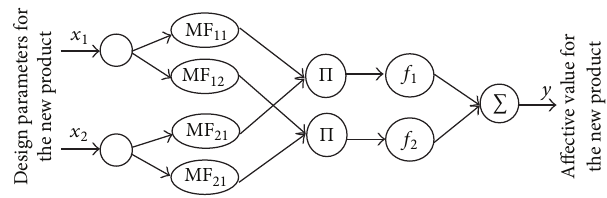
Figure 1: A five-layer structure of the dynamic NF model ( 𝐽 = 2 , 𝐾 = 2 ) for affective design.